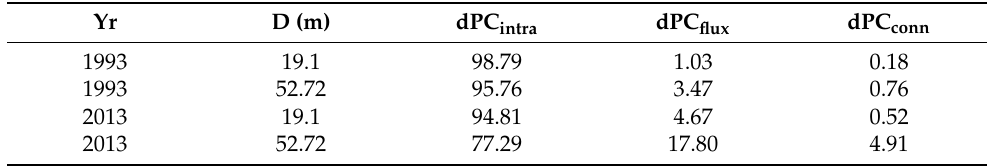
Table 3. Decomposition of dCP (intra, flux, and connector) for the varying dispersal distances D (meters) and years (yr)